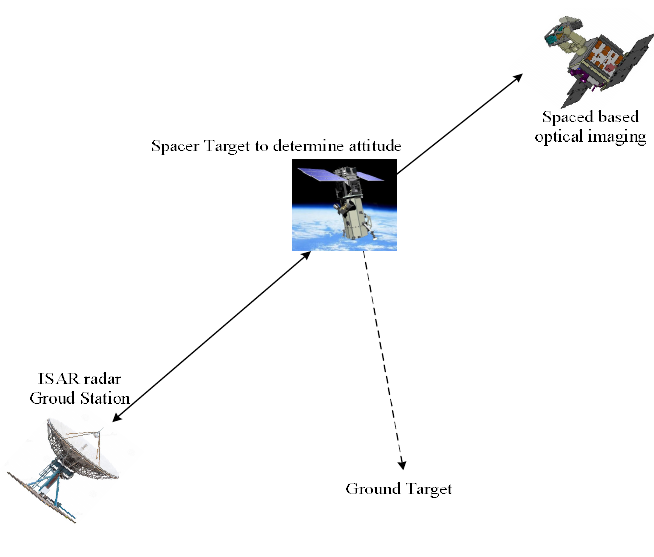
Figure 2. GSA scene.